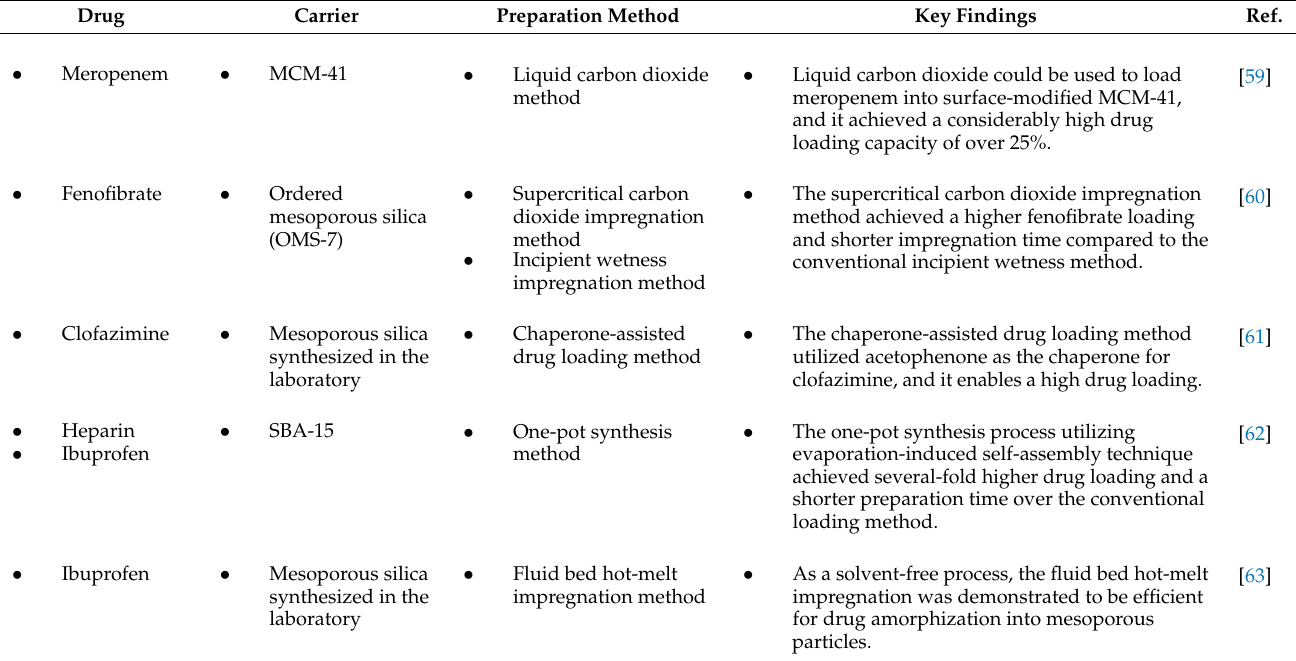
Table 5. Recent publications on the development of drug loading techniques for mesoporous particle-based amorphization. Drug Carrier Preparation Method Key Findings